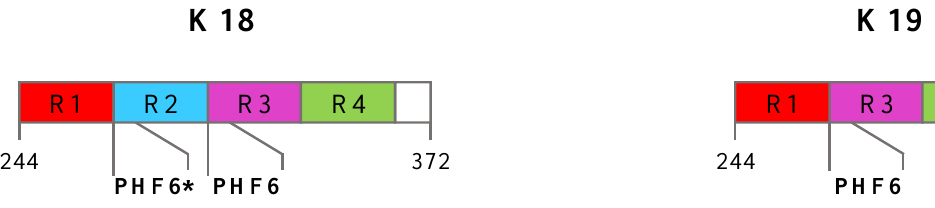
Figure 8. Tau constructs that form filaments. K18 and K19 correspond to the repeat domains of 2N4R and 0N3R, respectively. The relative locations of the hexapeptide motifs (PHF6* (VQIINK) and PHF6 (VQIVYK)), which are thought to act as nucleating segments for tau self-assembly are indicated. Biophysical studies of the self-assembly of full-length tau and model peptides in the presence of polyphenols (Figure 9) provide insights into mechanisms of inhibition. Rane et al. showed that 0N4R tau in the presence of arachidonic acid self-assembles to form β-sheet containing filaments [103]. In the presence of CUR, filament formation is abolished. Binding experiments indicated that CUR binds